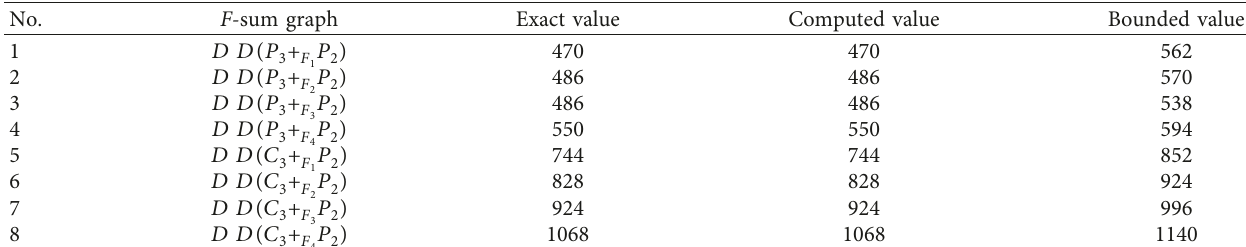
Table 5: Numerical comparison of DD index.